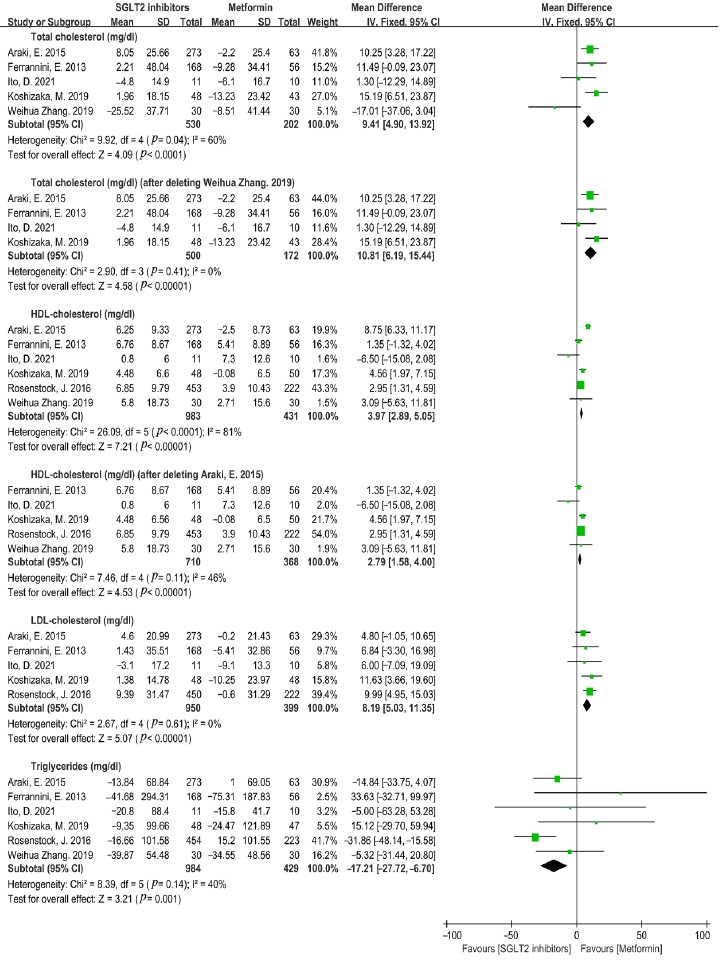
Figure 13. Weighted mean difference in change in blood lipid (mg/dL) from baseline from SGLT2i compared with metformin [20,23,26,28,29,32].